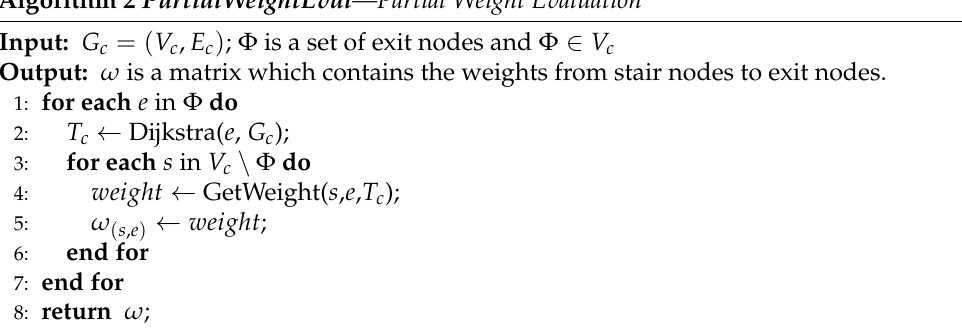
Algorithm 2 PartialWeightEval —Partial Weight